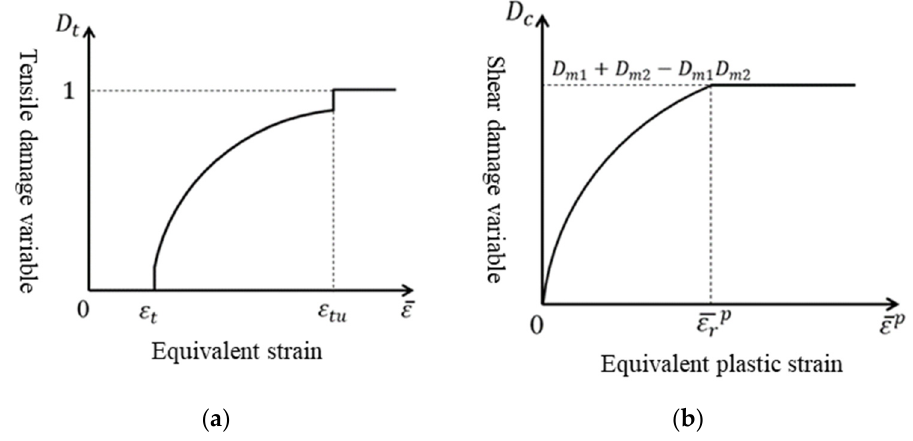
Figure 9. Schematic diagram of the evolution of damage variables under dual softening: ( a ) Tensile